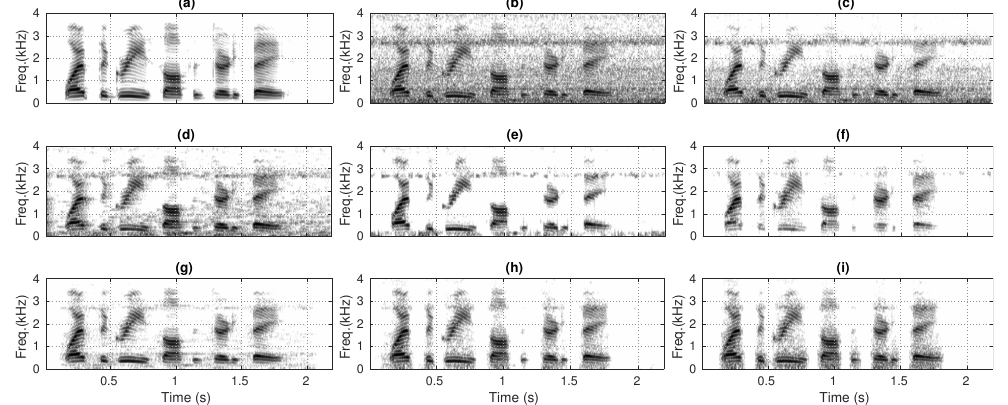
Figure 12. Comparing the spectrograms of: ( a ) clean speech (utterance sp05), ( b ) noisy speech (corrupt sp05 with 5 dB f16 noise) (PESQ = 2.14), enhanced speech produced by the: ( c ) KF-non-oracle (PESQ = 2.26), ( d ) MMSE-STSA [9] (PESQ = 2.39), ( e ) AKF-IT [13] (PESQ = 2.31), ( f ) AKF-RMBT [22] (PESQ = 2.53), ( g ) MDKF-MMSE (PESQ = 2.58), ( h ) proposed (PESQ = 2.65), and ( i ) KF-oracle (PESQ = 2.70)